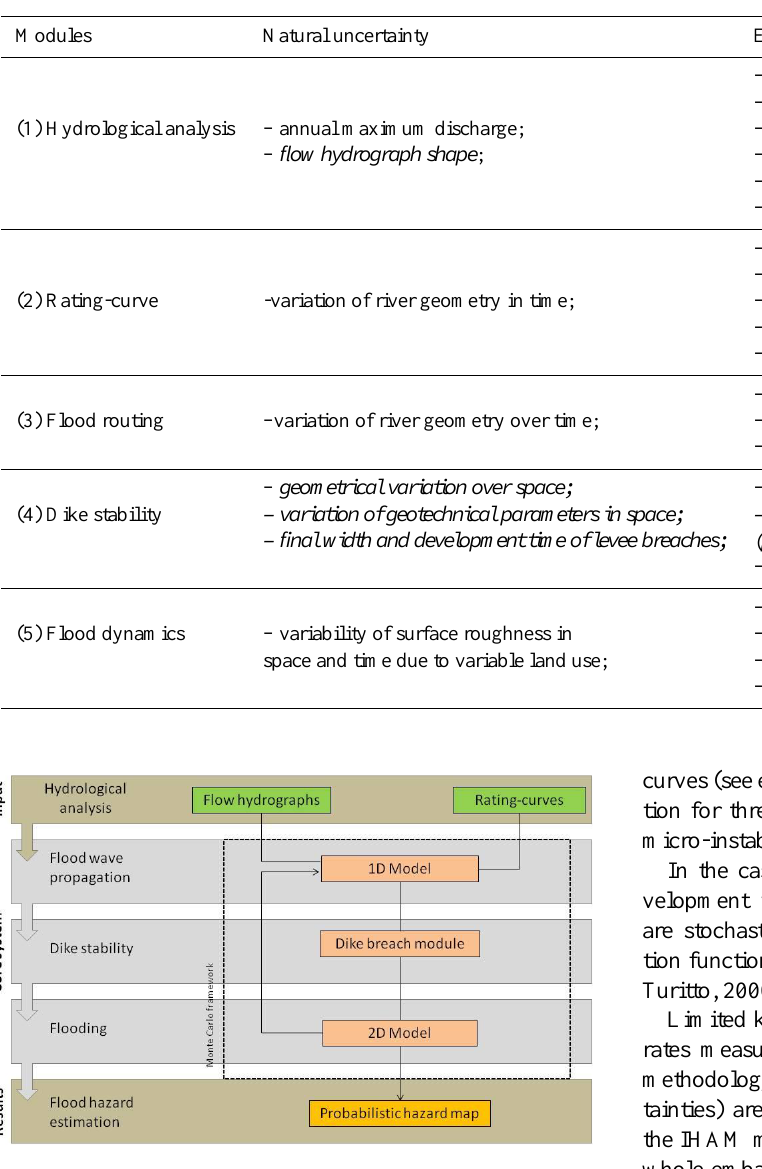
Fig. 2. Schematic structure of the IHAM model adopted for flood hazard estimation under uncertainty